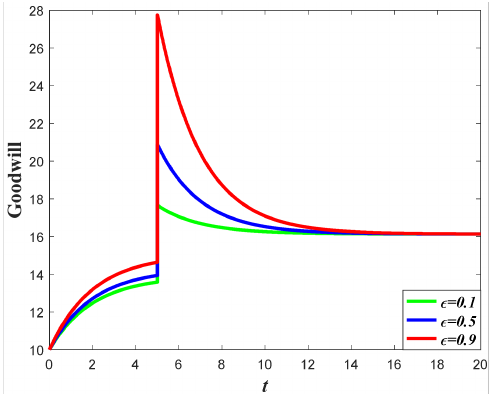
Figure 4. Impacts of ε on goodwill